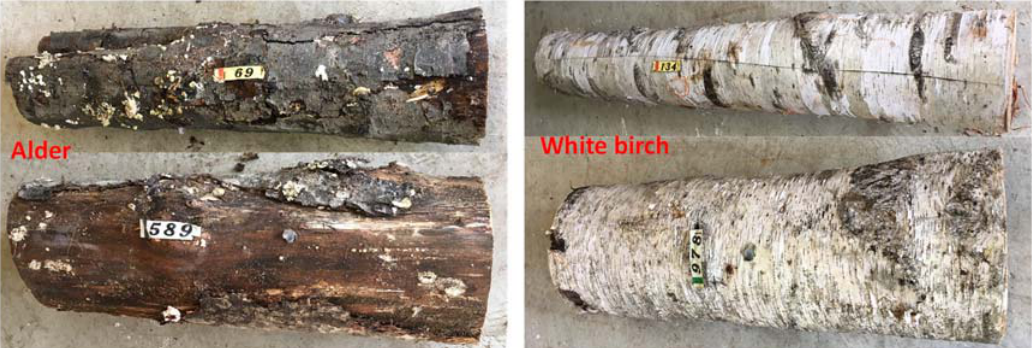
Figure 1. Logs of alder ( left ) and white birch ( right ) sampled in September 2018 (two years after being felled and exposed to beetle attack).